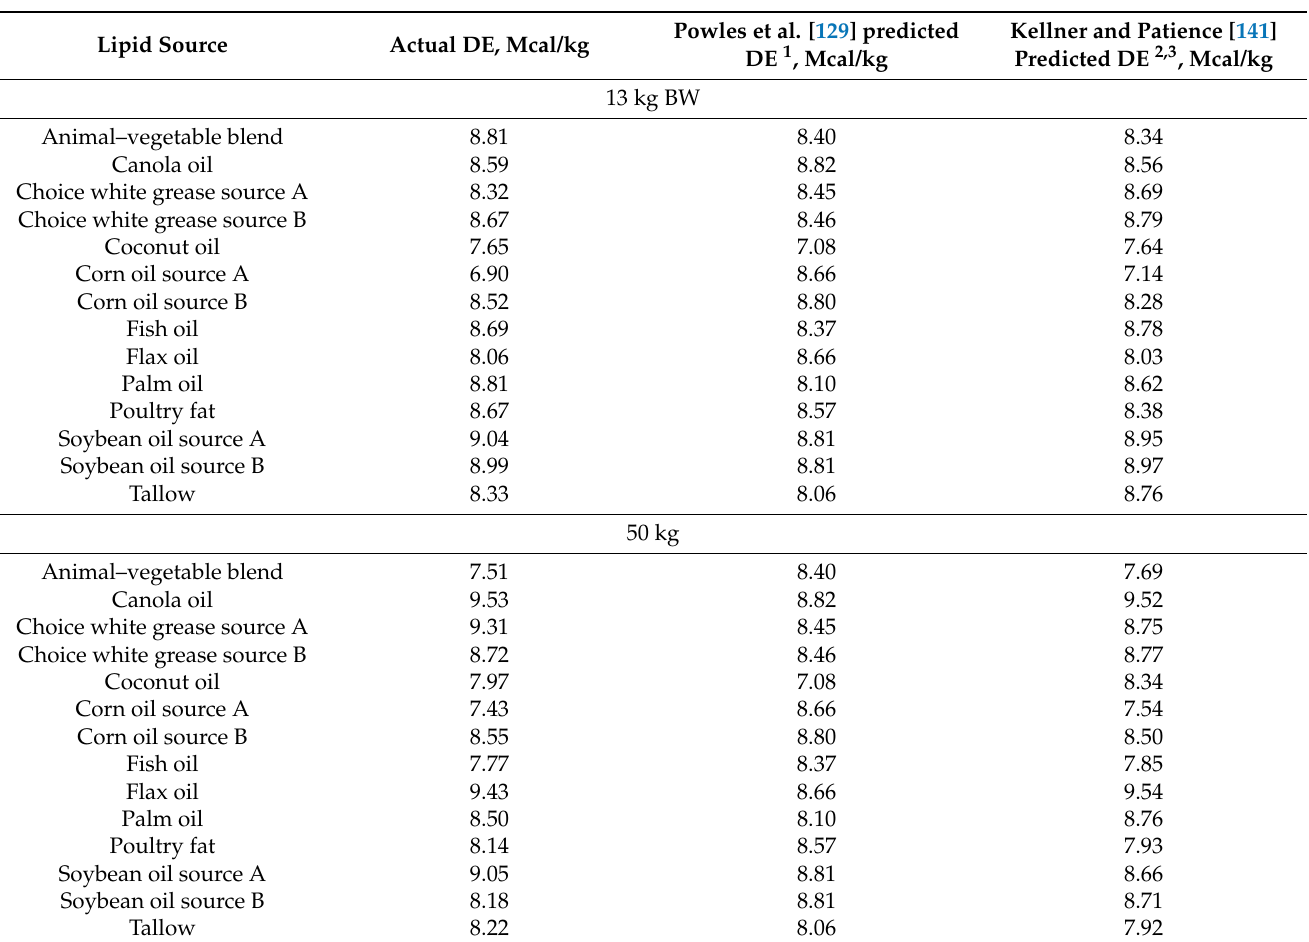
Table 10. Comparison of actual vs. predicted digestible energy (DE) of lipid sources fed to 13 kg and 50 kg pigs (adapted from